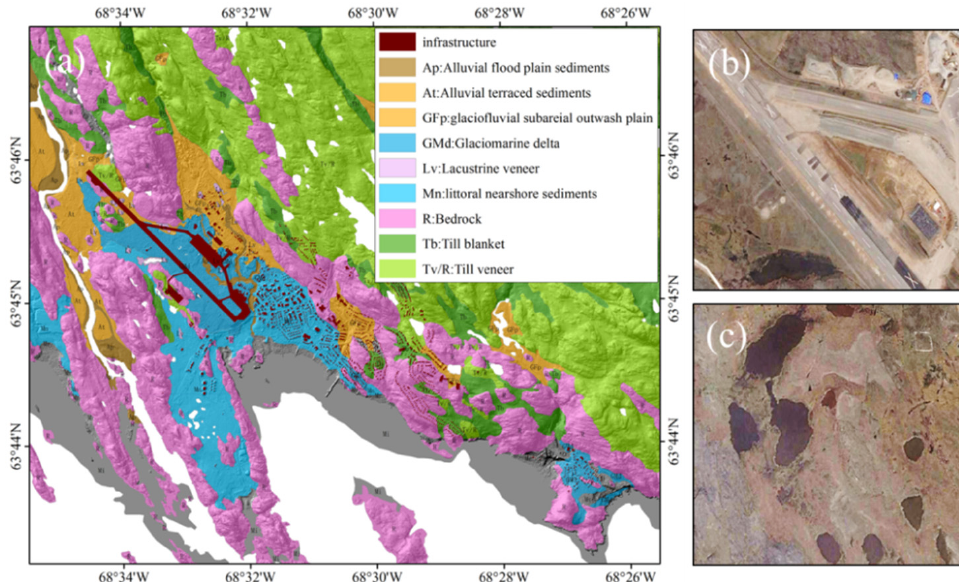
Figure 11. ( a ) Surficial geology map over Iqaluit; ( b ) optical image of the intersection of the runway and taxiway alpha; ( c ) optical image of landscape in Mn sediments.